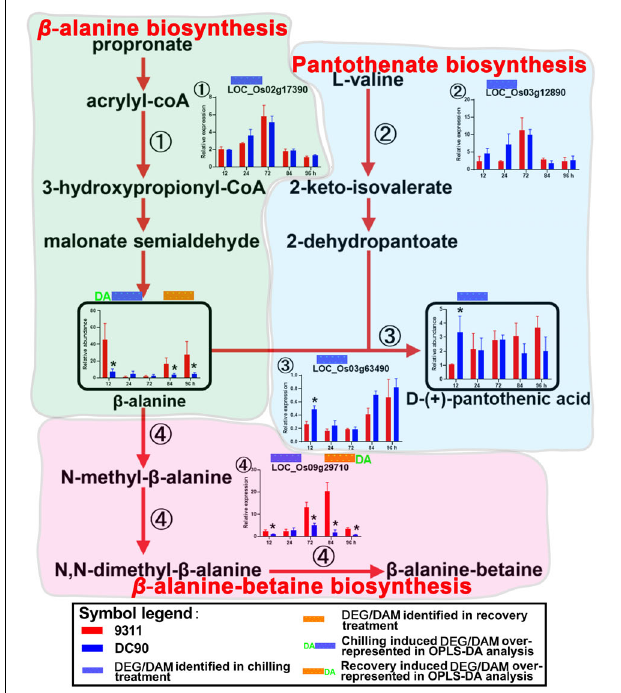
FIGURE 4 | Chilling- and/or recovery-induced DEGs and DAMs mapped to β -alanine biosynthesis and its related pathways. The boxed bar plots represent the metabolites with relative abundance alterations at certain timepoints in response to chilling (blue bar at the top) or recovery (orange bar at the top) treatment. The genes encoding the related enzymes with relative expression level alteration plots are numbered accordingly. The blue and orange bars at the top of the plot represent the transcripts or metabolites that are significantly altered in response to chilling (blue bar) and/or recovery (orange bar) treatment. The plot of transcript or metabolites with the green letters DA to the left of the blue bar or to the right of the orange bar represents the transcript or metabolite members of discriminatory DEGs/DAMs that play key roles in differentiating the chilling tolerance capacity of 9311 and DC90. The red arrows represent overall upstream/downstream relationships in the related pathways, respectively. *Significant at P ≤ 0.05 level according to Student’s t